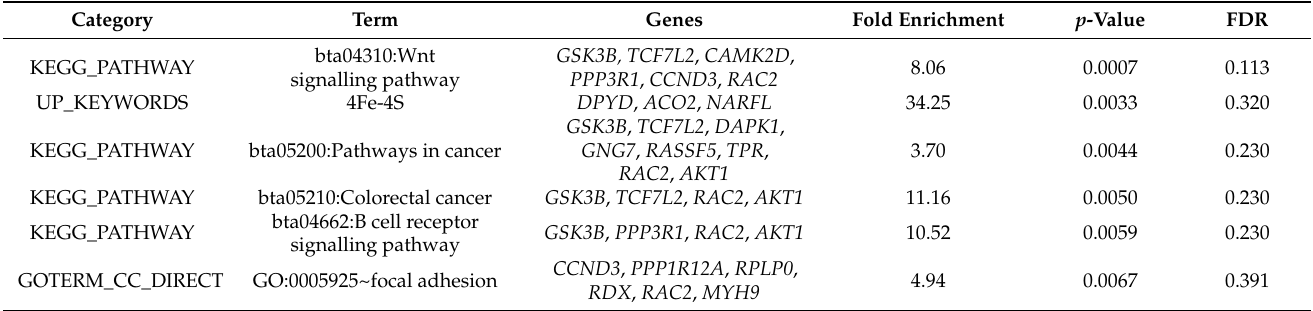
Table 4. DAVID functional annotation analysis of 38 genes identified containing variants which differed between E. coli (+) and E. coli ( − ) cows, showing the top 6